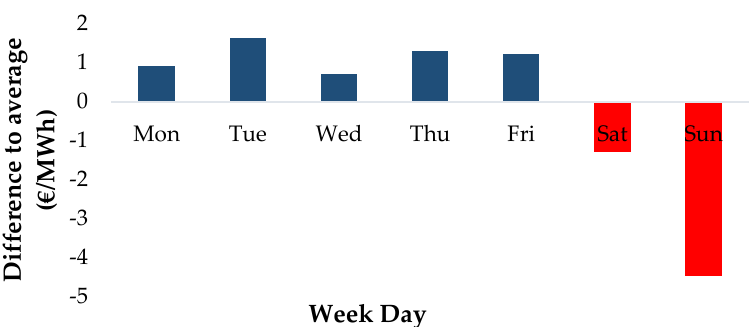
Figure 3. Di ff erence between the year average and each day of the Figure 3. Difference between the year average and each day of the week.